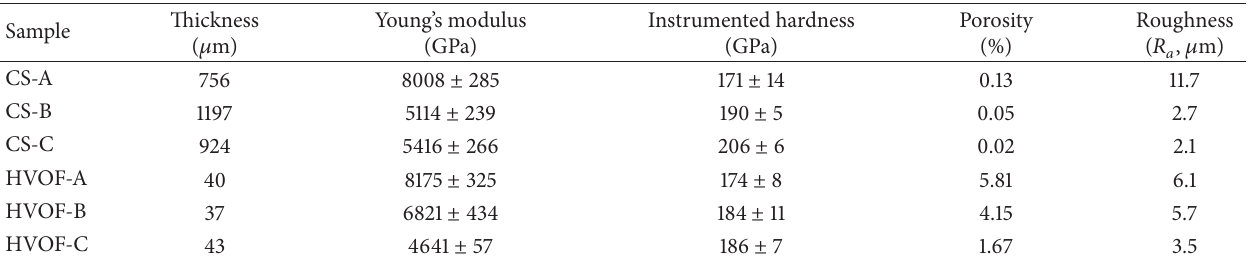
Table 1: Properties of as-sprayed and EB treated samples.